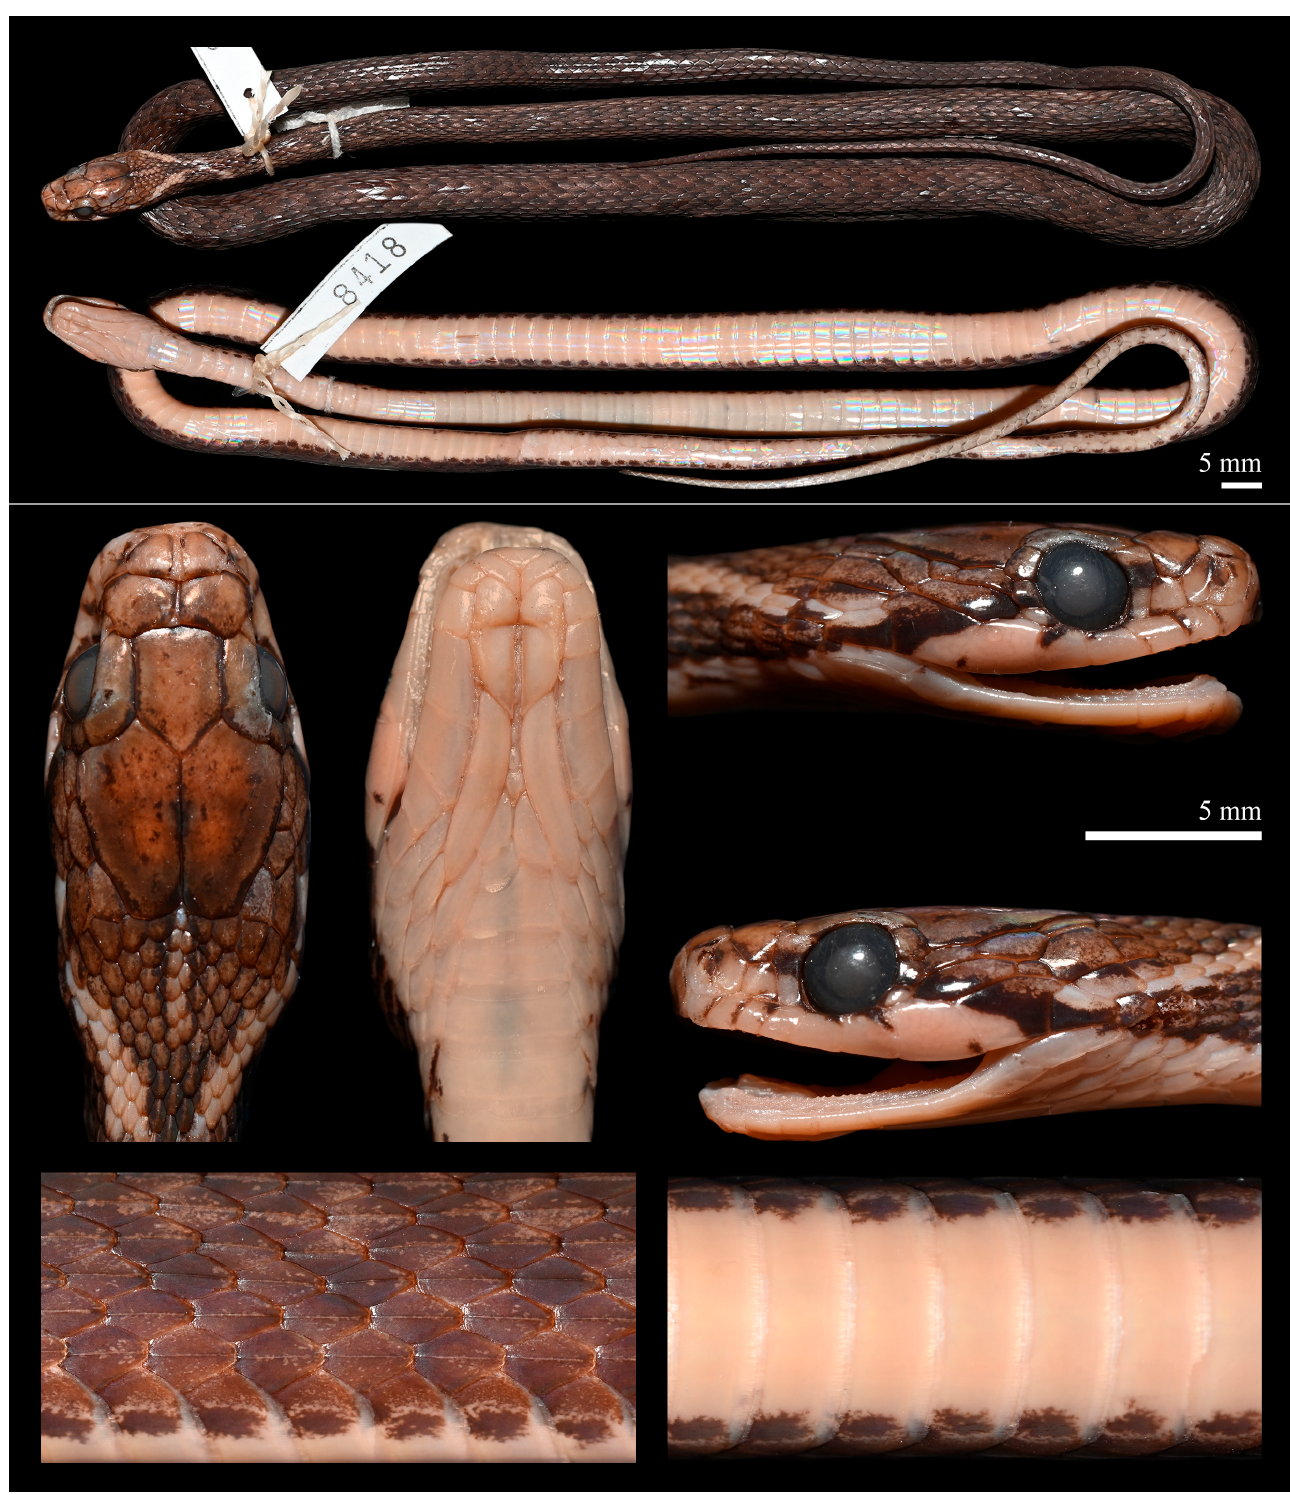
Figure 9. Preserved holotype of Herpetoreas tpser sp. nov. , CIB 8418, adult male, Beibeng, Mêdog County, Xizang Autonomous Region, China. Photographs by Jun ‐ Jie Huang.